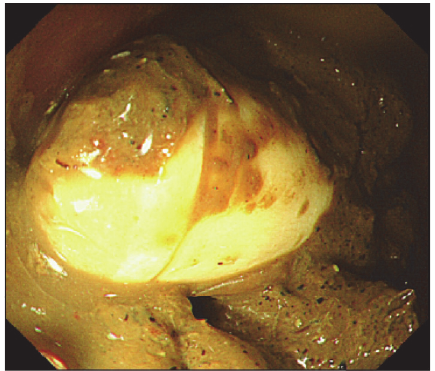
Figure2:Colonoscopydisplayingtheanastomoticstenosisbetween the rectum and the sigmoid colon.